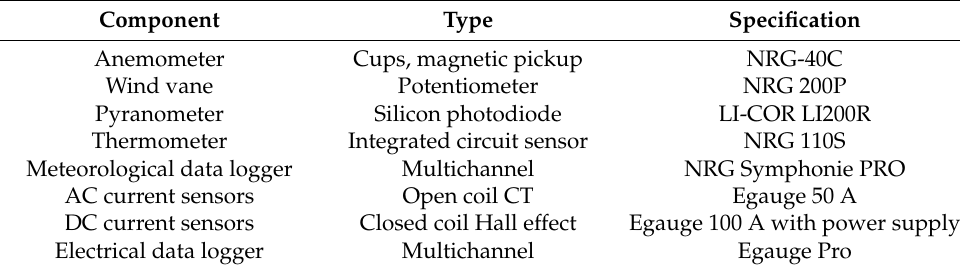
Table 2. Measuring equipment